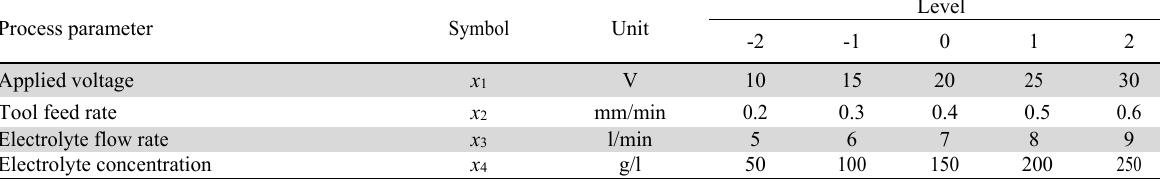
ECM process parameters along with their levels (Mehrvar et al., 2017) Level Process parameter Symbol Unit -2 -1 0 1 2 Applied voltage x 1 V 10 15 20 25 30 Tool feed rate x 2 mm/min 0.2 0.3 0.4 0.5 0.6 Electrolyte flow rate x 3 l/min 5 6 7 8 9 Electrolyte concentration x 4 g/l 50 100 150 200